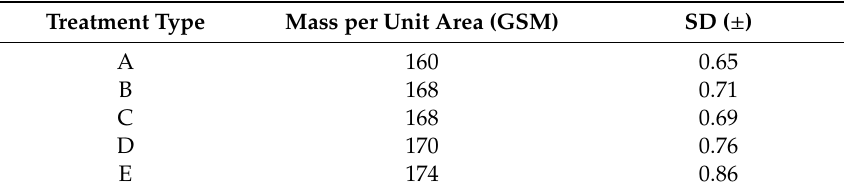
Figure 1. Effect of finishes on mas per unit area of the fabric (A) grey fabric, (B) simple wash, (C) normal finish, (D) silicon finish, and (E) wicking finish. Table 3. E ff ect of finishes treatments on the mass per unit area (GSM)